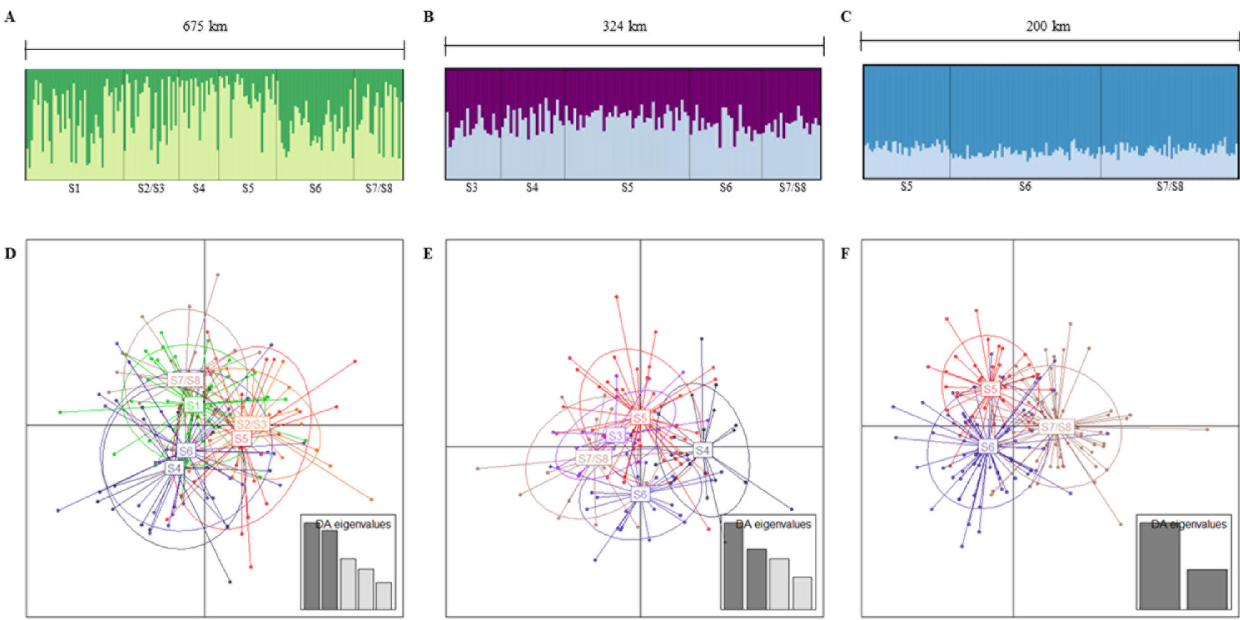
FIGURE 2 | Population structure suggested by STRUCTURE ( A – C ) and the Discriminant Analysis of the Principal Components ( D – F ) for Pimelodus grosskopfii ( A , D ), Sorubim cuspicaudus ( B , E ), and Ageneiosus pardalis ( C , F